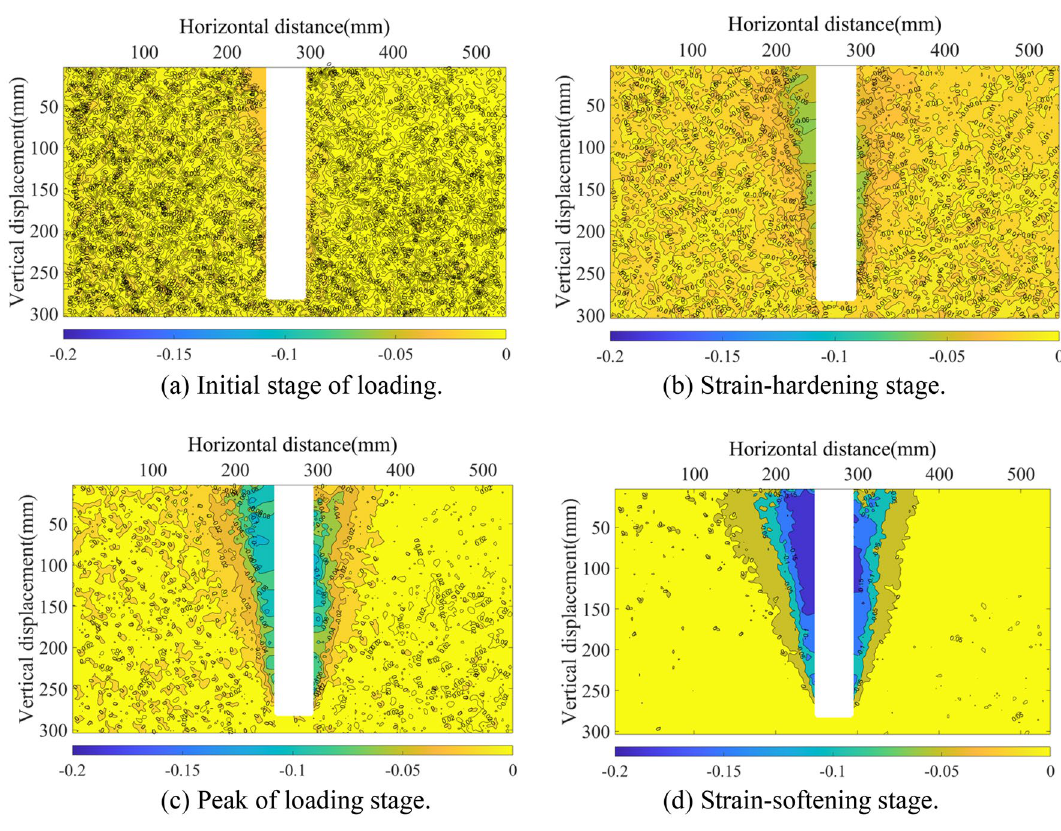
Figure 5. Soil displacement contour